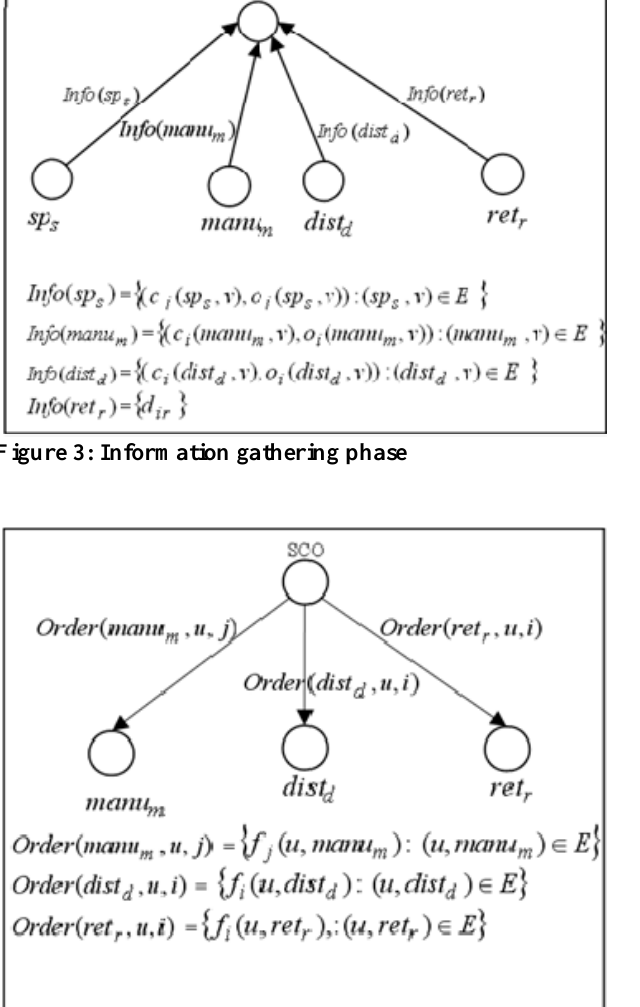
Figure 4:Sending order quantities phase